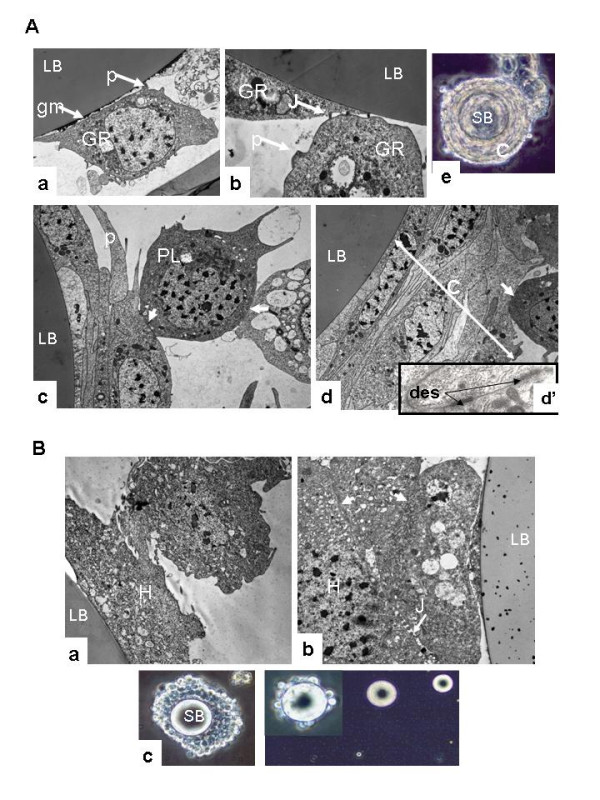
Encapsulation of beads in Spodoptera frugiperda last instar larvae. A. Time course of encapsulation, by transmission electronic and photonic observations. a) Bead 30 minutes post-injection (p.i.). Beads are covered by an uncharacterized granular material (as described in Galleria mellonella by Schmit and Ratcliffe [115]). b) Bead 1 hour p.i. c) Bead 2 hours p.i. d) Bead 4 hours p.i. d') Detail showing desmosomes between two cells involved in the capsule. e) Bead 24 hours p.i. (phase contrast observation). B. Effect of injection of HdIV on cellular response. In a) and b) HdIV have been injected 5 hours prior to the beads, in c) HdIV and beads were injected simultaneously. a) Bead 15 hours p.i. b) Bead 6 hours p.i. c) Beads 24 hours p.i. (phase contrast observation). LB: latex bead; C: capsule; gm: granular material; des: desmosome-like junction; H: hemocyte; J: cellular junction; p: pseudopode-like extension; SB: sephadex bead; arrowheads indicate cells already partially attached to each other. The scale bar corresponds to 1 μm in all views, with exception of Figure 1d'), where the scale bar corresponds to 0.5 μm.